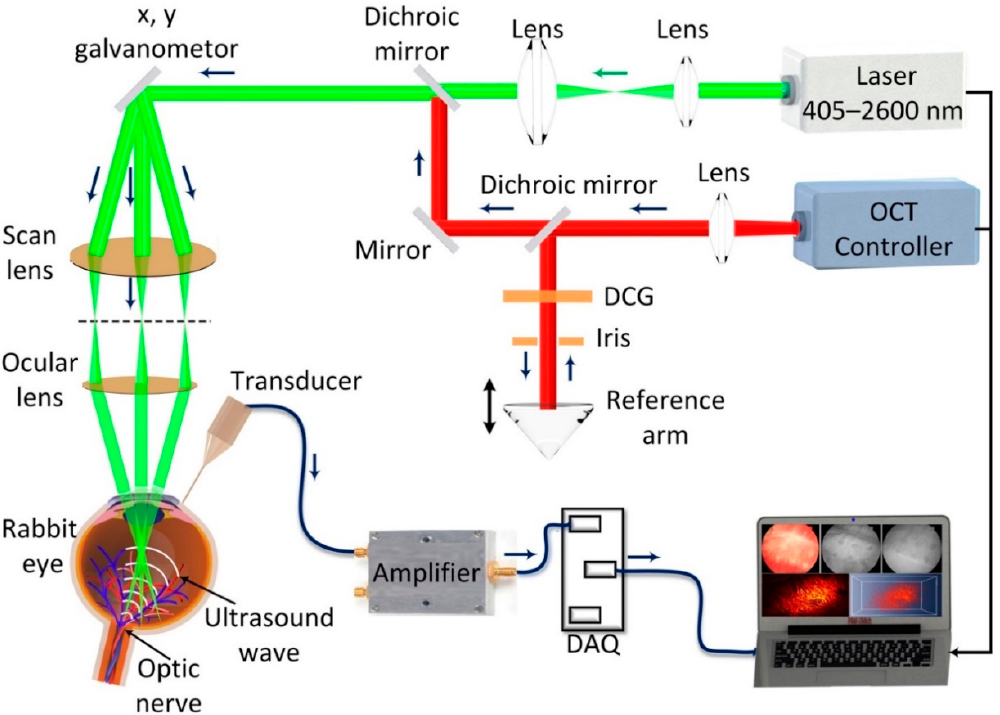
Figure 7. Schematic of the high resolution, multimodal photoacoustic microscopy and optical coherence tomography imaging system. DCG: dispersion compensation glass.